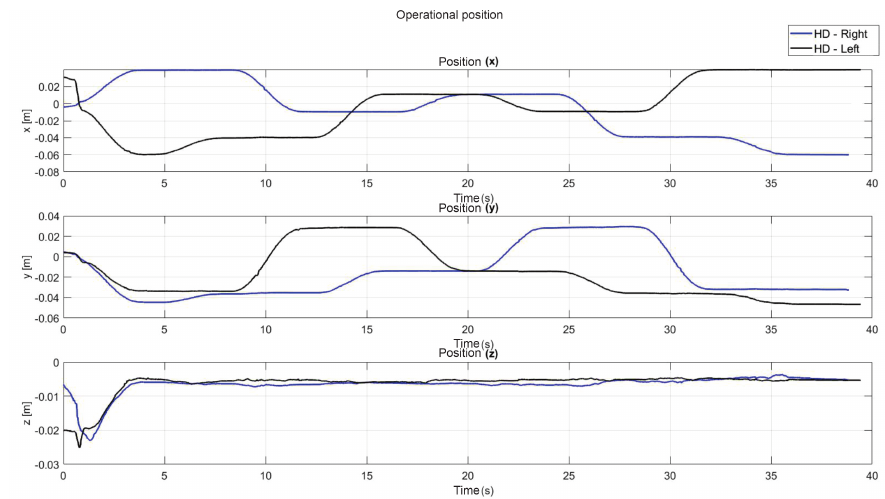
Figure 18. Operational position of two haptic devices in passive haptic guidance task: exercise 1.